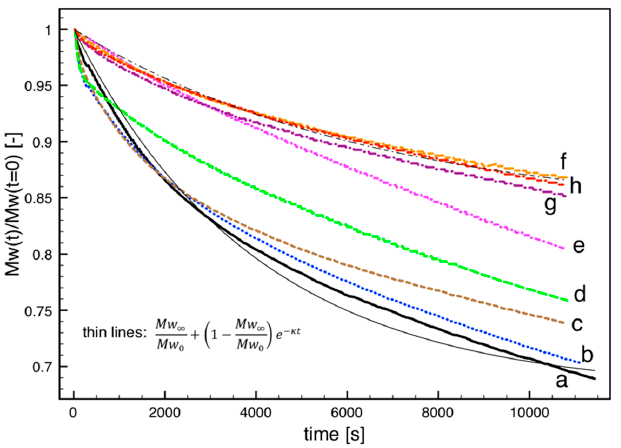
Figure 5. Time sweep-complex viscosity for the virgin PLA pellet ( a ) and for extruded samples after microcompounding: ( b ) neat and with ( c ) 0.1 wt % of LSAG; ( d ) 1 wt % of LSAG; ( e ) 0.1 wt % of HSAG; ( f ) 1 wt % of HSAG; ( g ) 0.1 wt % of CB; ( h ) 1 wt % of CB. Experimental conditions: T = 200 °C, f = 1 rad/s, plate–plate, gap = 200 μ m.